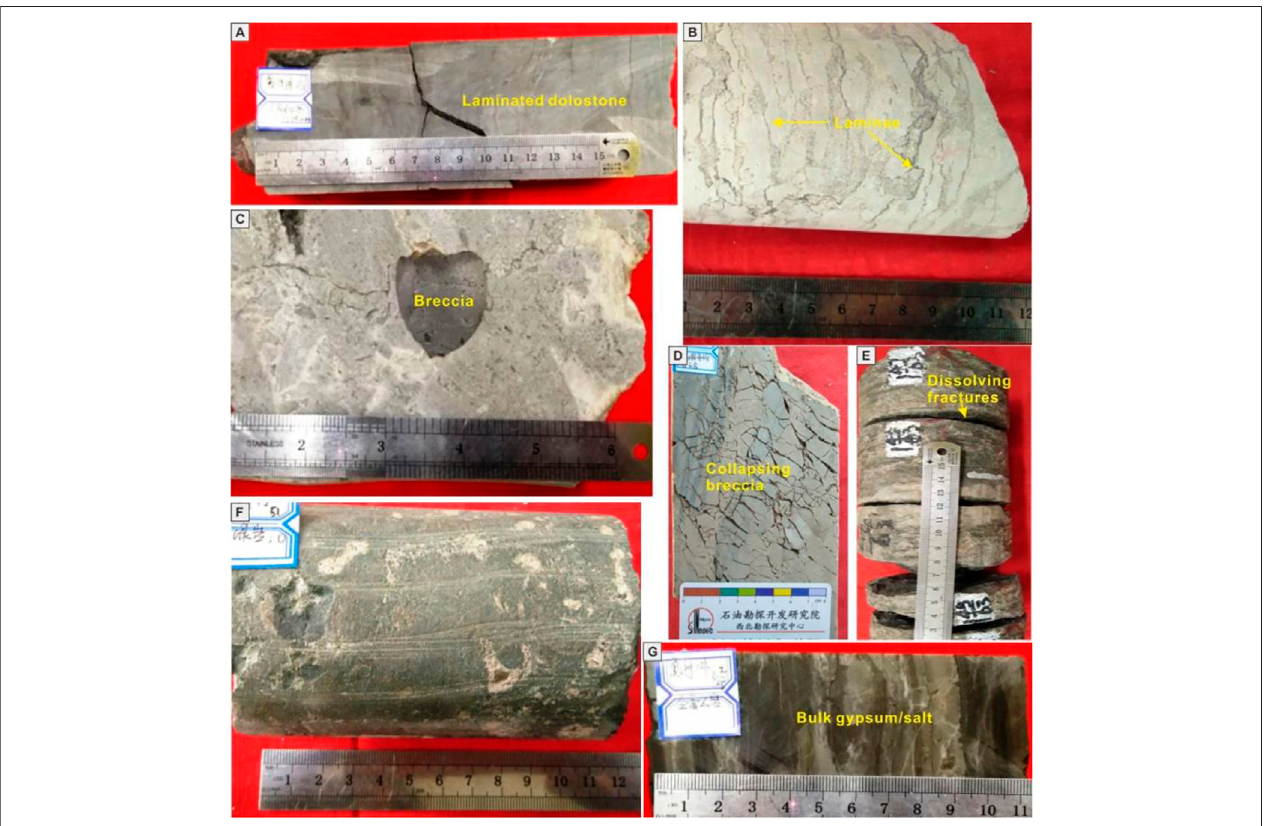
FIGURE 2 | Core sample photographs showing lithofacies of the studied interval in the Ma5 member. (A) Micritic dolomite matrix showing laminated layers. (B) Stromatolites developing thin layers of different colors. (C) Dolomite breccias. (D) Breccias collapsing in the studied interval, leaving visible fractures. (E) Fractures developing in bulky dolostones. (F) Silty dolomites developing no visible pores. (G) Gypsum developing in upper tidal- fl at sabkha environment.